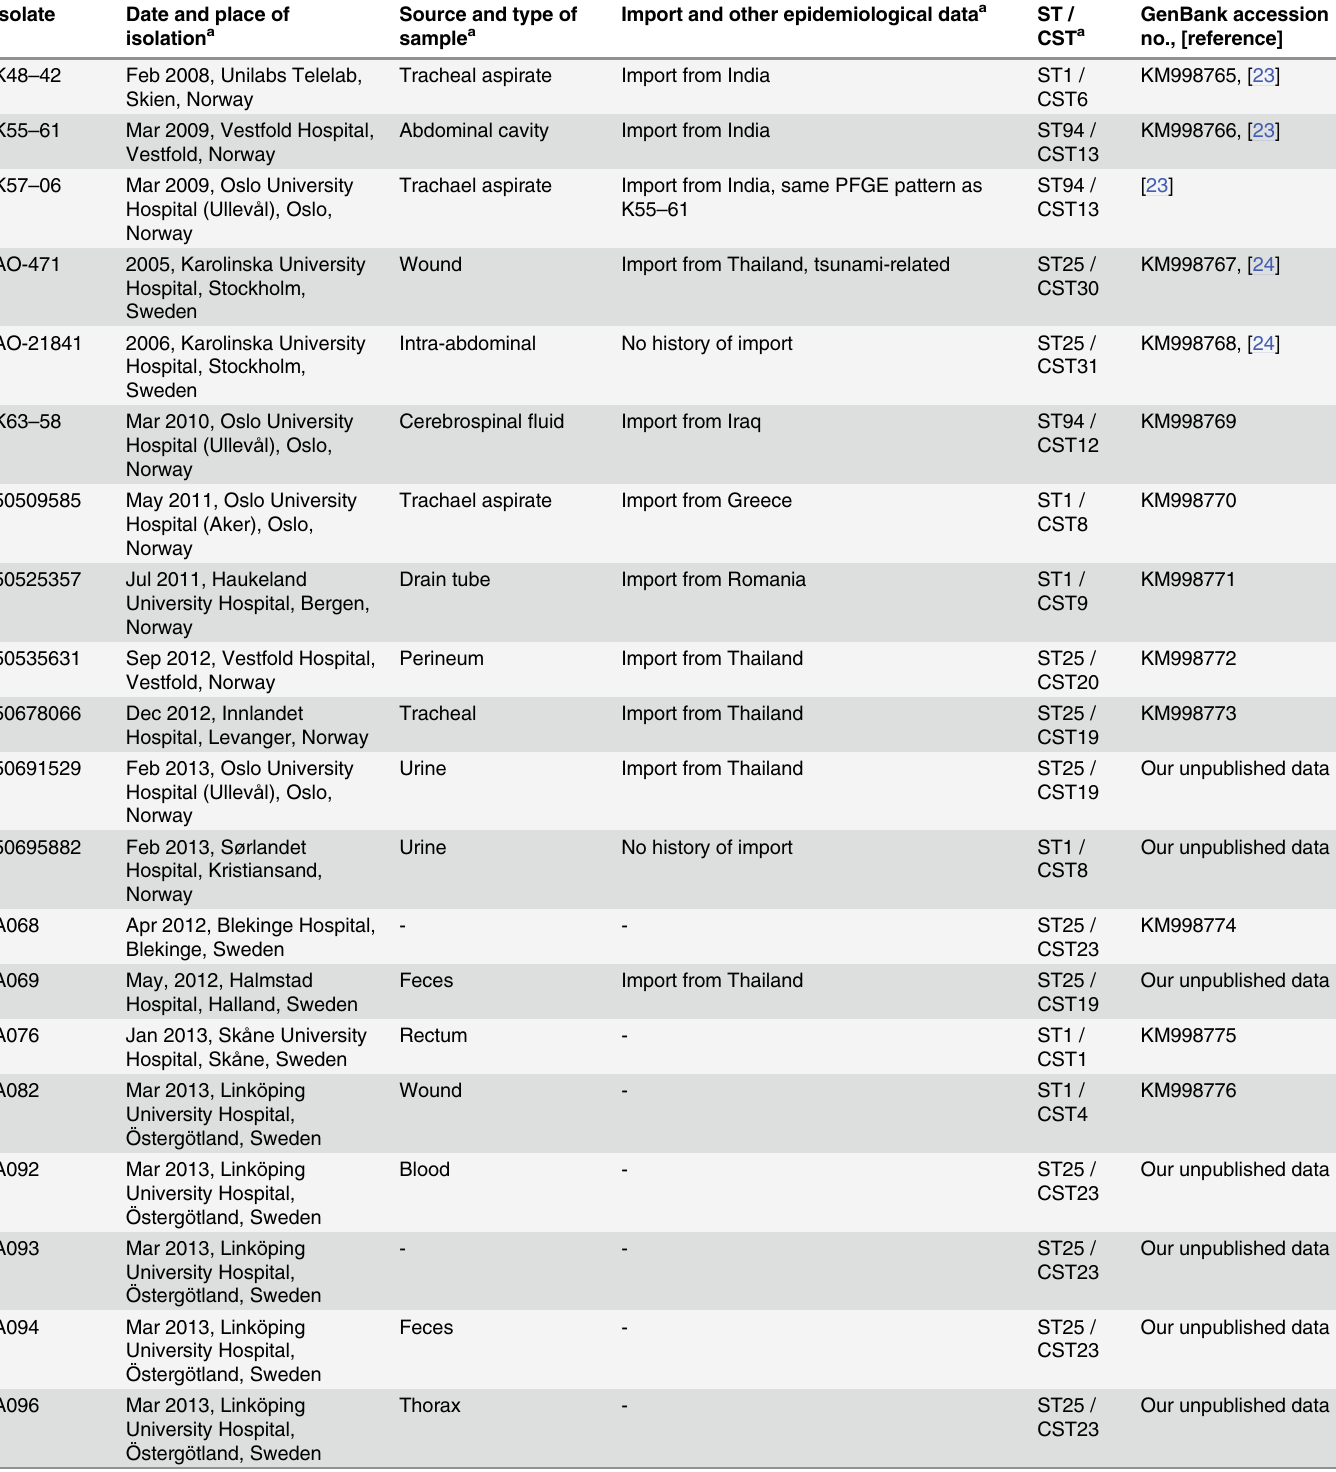
Table 1. Epidemiological data on the 74 Acinetobacter baumannii isolates included in this study.